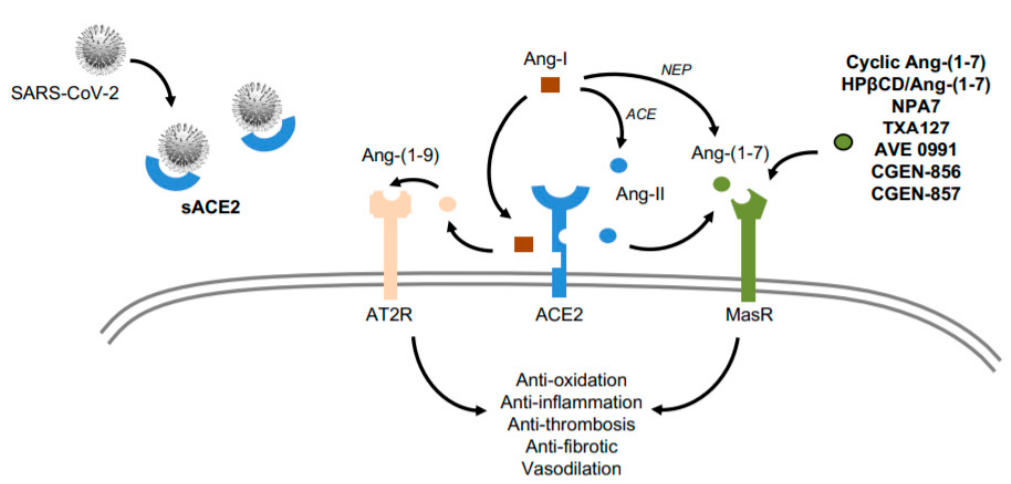
Figure 3. Role of sACE2 and MasR activators in COVID-19. Infusion of the soluble isoform of ACE2 could serve as a decoy receptor for SARS-CoV-2 particles, reducing infectivity while conserving cardioprotective actions of the plasma membrane isoform (via Ang-(1–9) and Ang-(1–7)). On the other hand, some Ang-(1–7) mimetics (cyclic Ang-(1–7), HP β CD-Ang-(1–7), NPA7, TXA127) and MasR agonists (AVE 0991, CGEN-856, CGEN-857) could also trigger protective actions for the CV system in COVID-19 subjects. Ang and ACE stand for angiotensin and angiotensin converting enzyme, respectively. sACE2 and NEP stand for soluble ACE2 and neprilysin, respectively. MasR and AT2R stand for Mas receptor and angiotensin receptor type-II, respectively. Finally, HP β CD-Ang-(1–7) means hydroxypropyl β